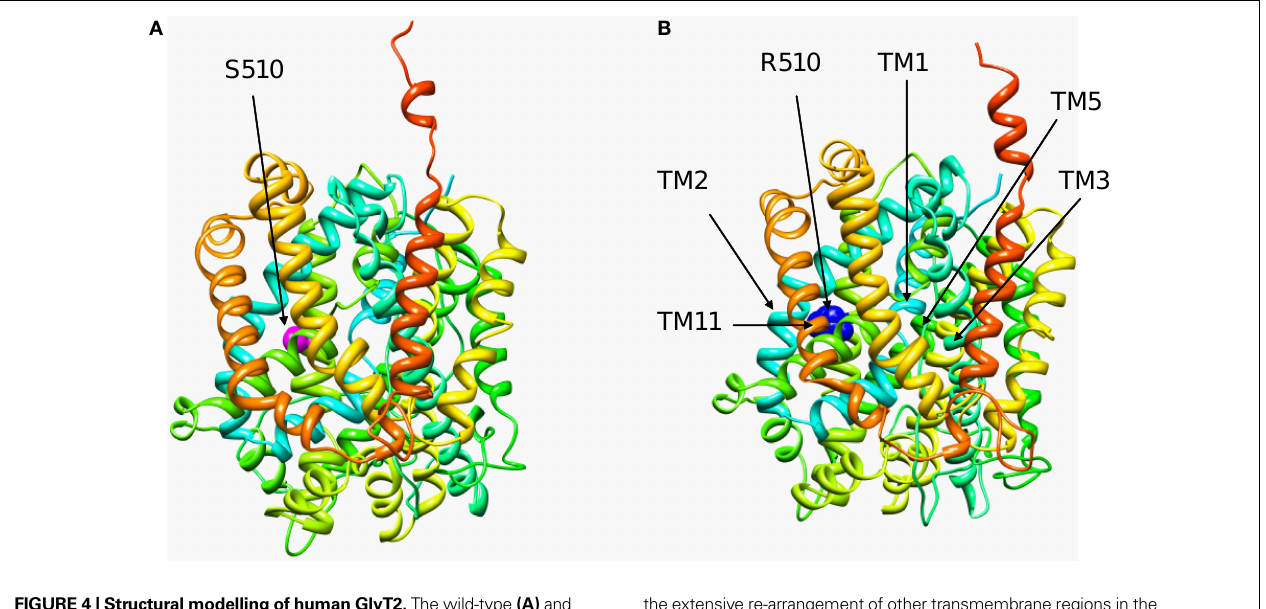
FIGURE 4 | Structural modelling of human GlyT2. The wild-type (A) and the S510R mutant (B) model were generated based on homology with the crystal structure of LeuT, a bacterial Na + /Cl − -dependent neurotransmitter transporter homologue (PDB: 2A65). The models cover residues 191–754 of GlyT2 and show the position of the S510R mutation in TM7 along with